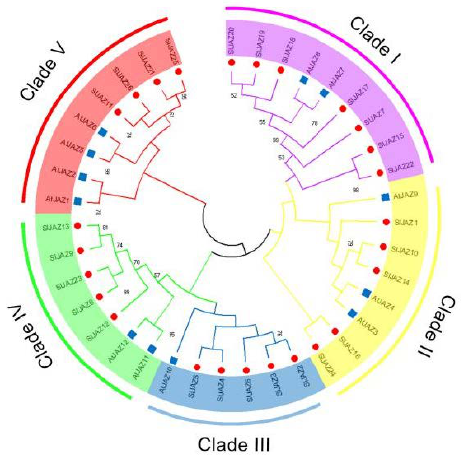
Figure 2. Phylogenetic relationships of 26 SlJAZs in tomato and 12 AtJAZ protein sequences in A. thaliana . Different branches are shown in different colors. Nodes with a bootstrap support value of less than 50 are not shown.